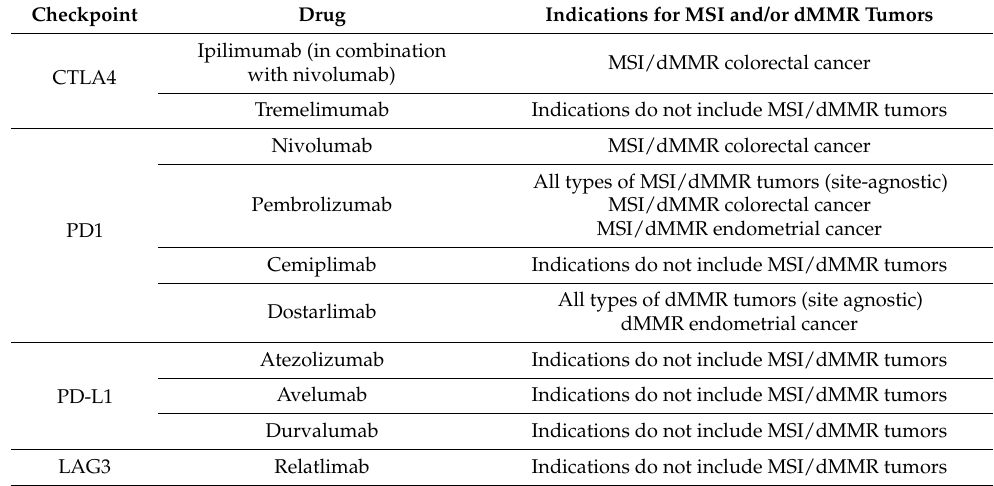
Table 1. dMMR/MSI-related indications for immune checkpoint